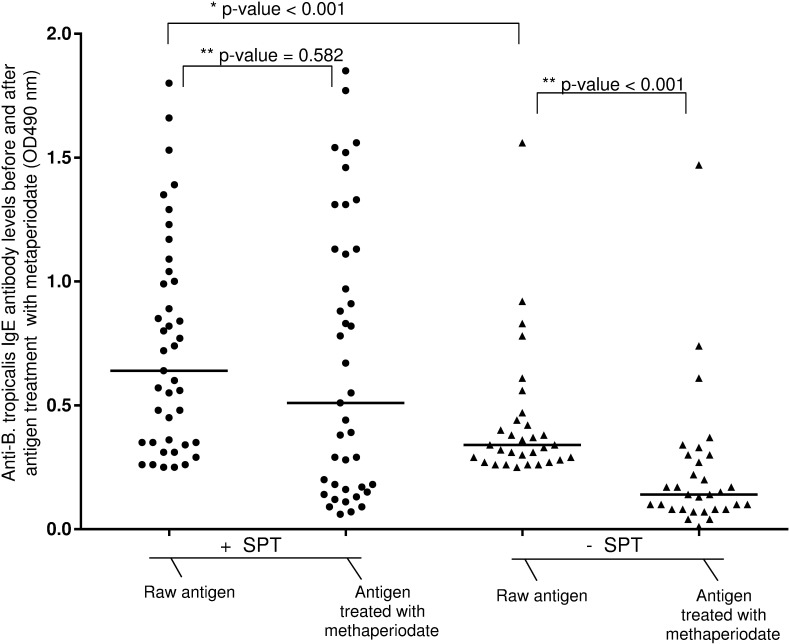
Anti-Blomia tropicalis IgE levels in serum samples assayed using as antigens B. tropicalis extract depleted or not of carbohydrate.Anti-Blomia tropicalis IgE levels were measured by indirect in-house ELISA in individuals positive for this antibody in IMMUNOCAP and were divided in two groups: SPT negative or positive for the same allergen. Antigen was treated with methaperiodate and the sera were assayed against raw and methaperiodate treated antigens. *Difference of sIgE results between SPT positive and SPT negative children (Mann–Whitney test). **Difference of sIgE results before and after antigen treatment with methaperiodate (Wilcoxon test).